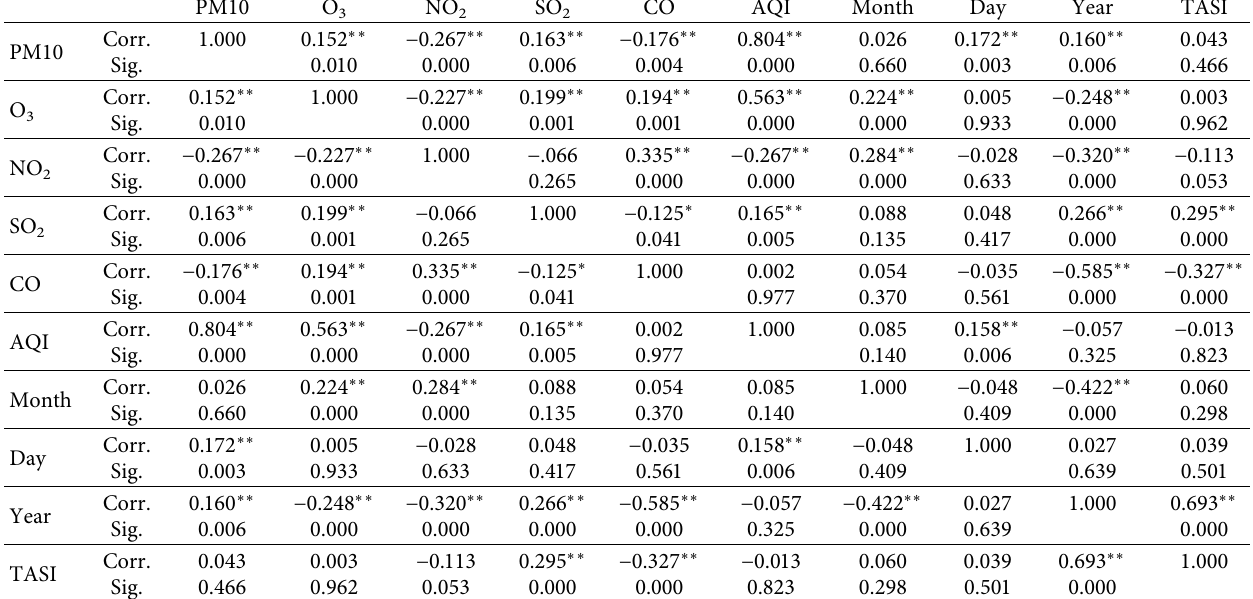
Table 2: Correlation